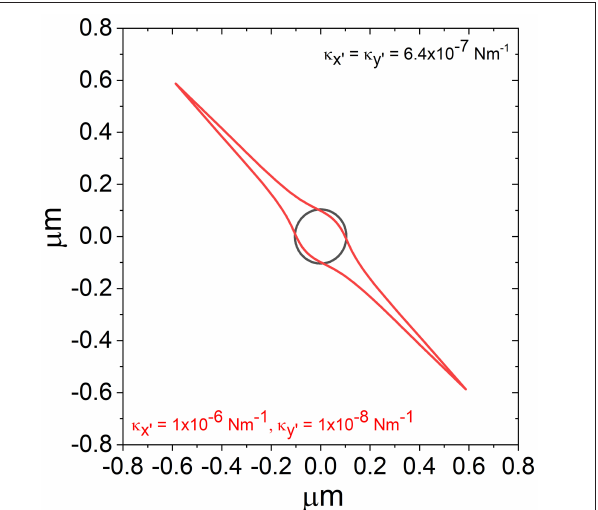
κ r 2 , for a trap of the same 2